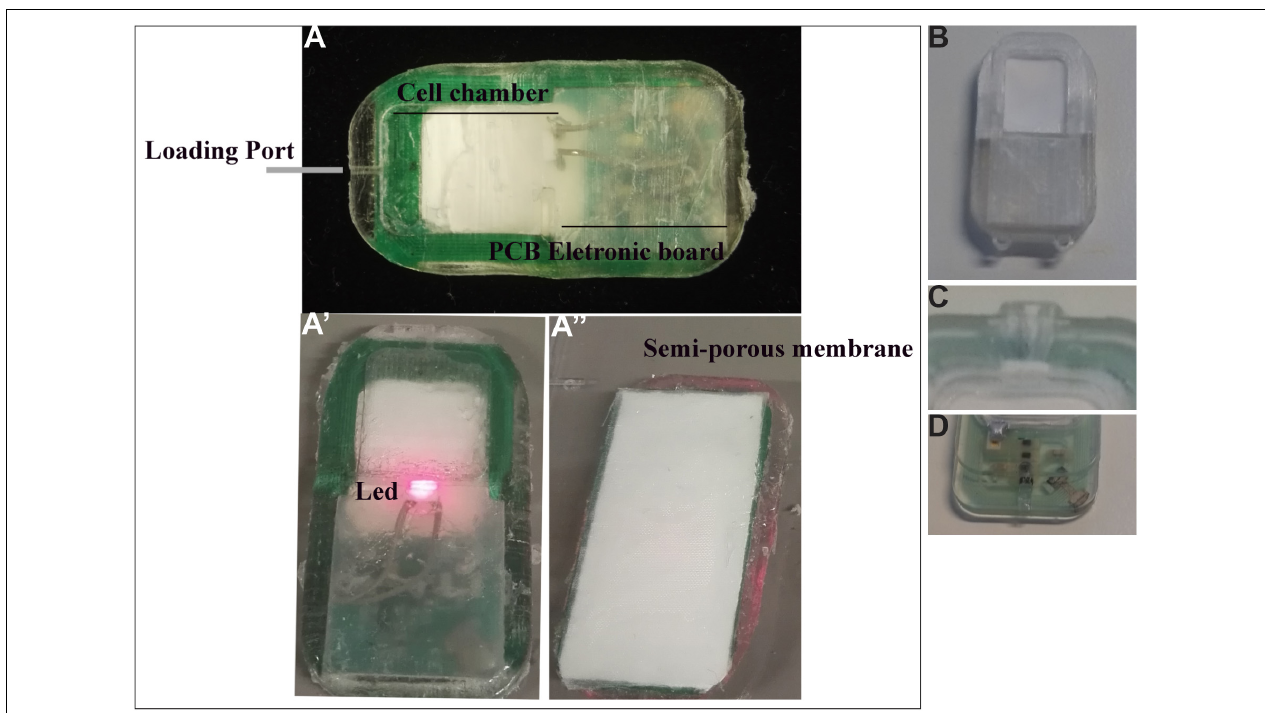
FIGURE 2 | Different types of devices implanted in mice. (A–A”) Different compounds of the bioelectronic cell-based device: the loading port allows to load cells in the cell chamber (A) ; PCB electronic board (A) integrates the energy harvesting antenna, the rectifying circuit powering a 680 nm LED (A’) . The device cell-chamber membrane confinement barrier is composed of a semi-porous hydrophilic polypropylene membrane (A”) . (B) 3D-printed implant. (C,D) Silicone implants; (C) shows the pore to load cells in the implant, and this part creates friction on the skin of the animal, thus promoting lesions; (D) indicates the second layer of silicone in which a problem of permeability was